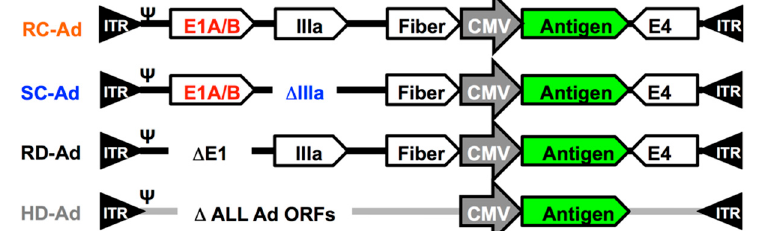
Figure 1. Adenovirus vaccines. Key Ad and adenovirus genes relevant to the vaccine functions are shown. Replication-competent RC-, single-cycle SC-, and replication-defective (RD)-Ads all carry most Ad open reading frames (ORFs) (not shown). HD-Ads are deleted for all of these adenovirus ORFs.